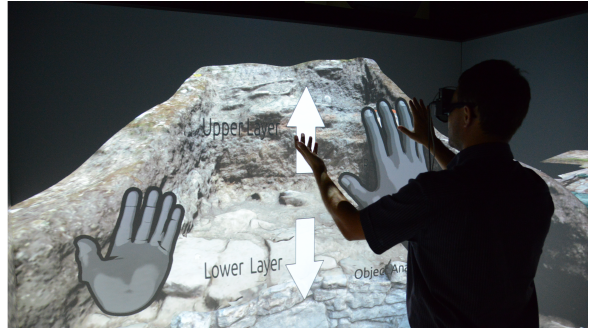
Figure 11. The new application within the